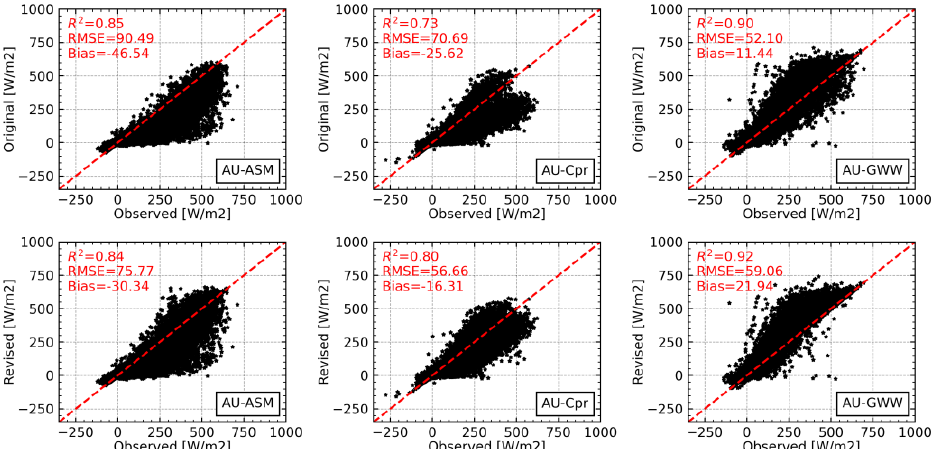
Figure 2. Relationship between the observed and simulated sensible heat flux by the original and the revised parameterization at savannah